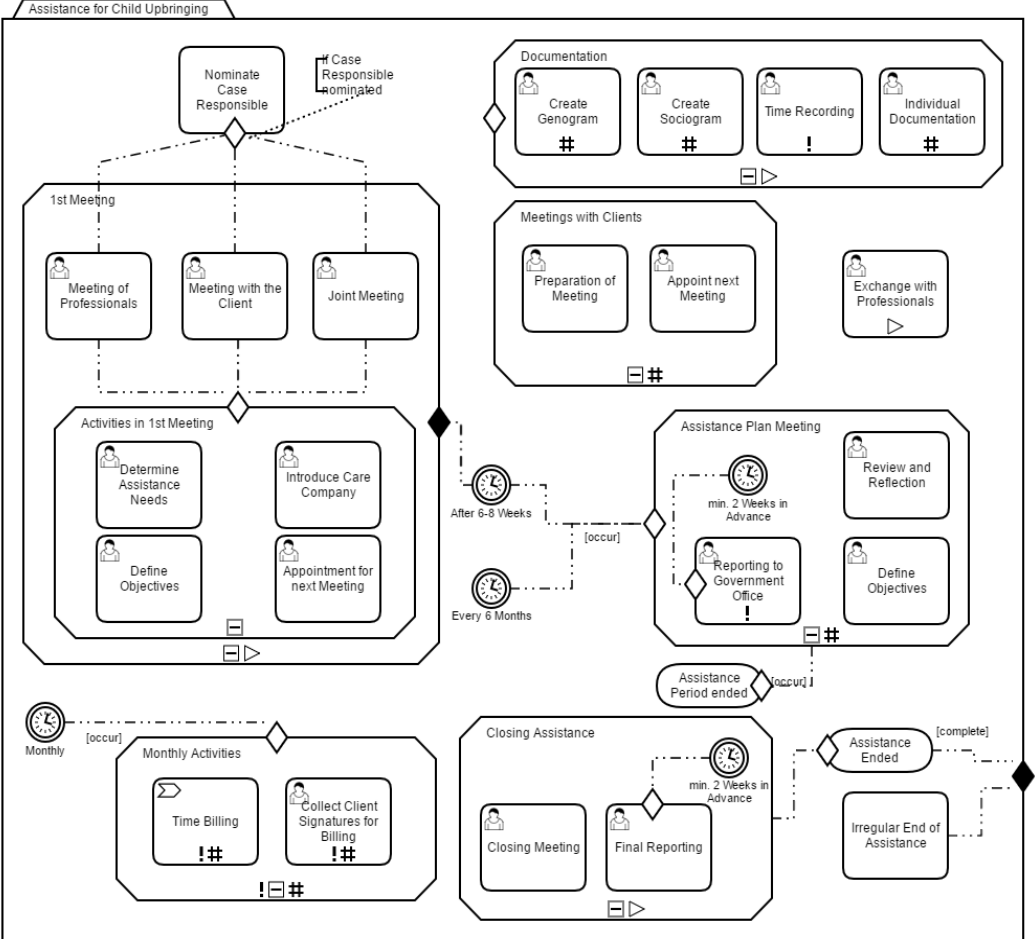
Figure 5. Case Template “Assistance for Child Upbringing” in